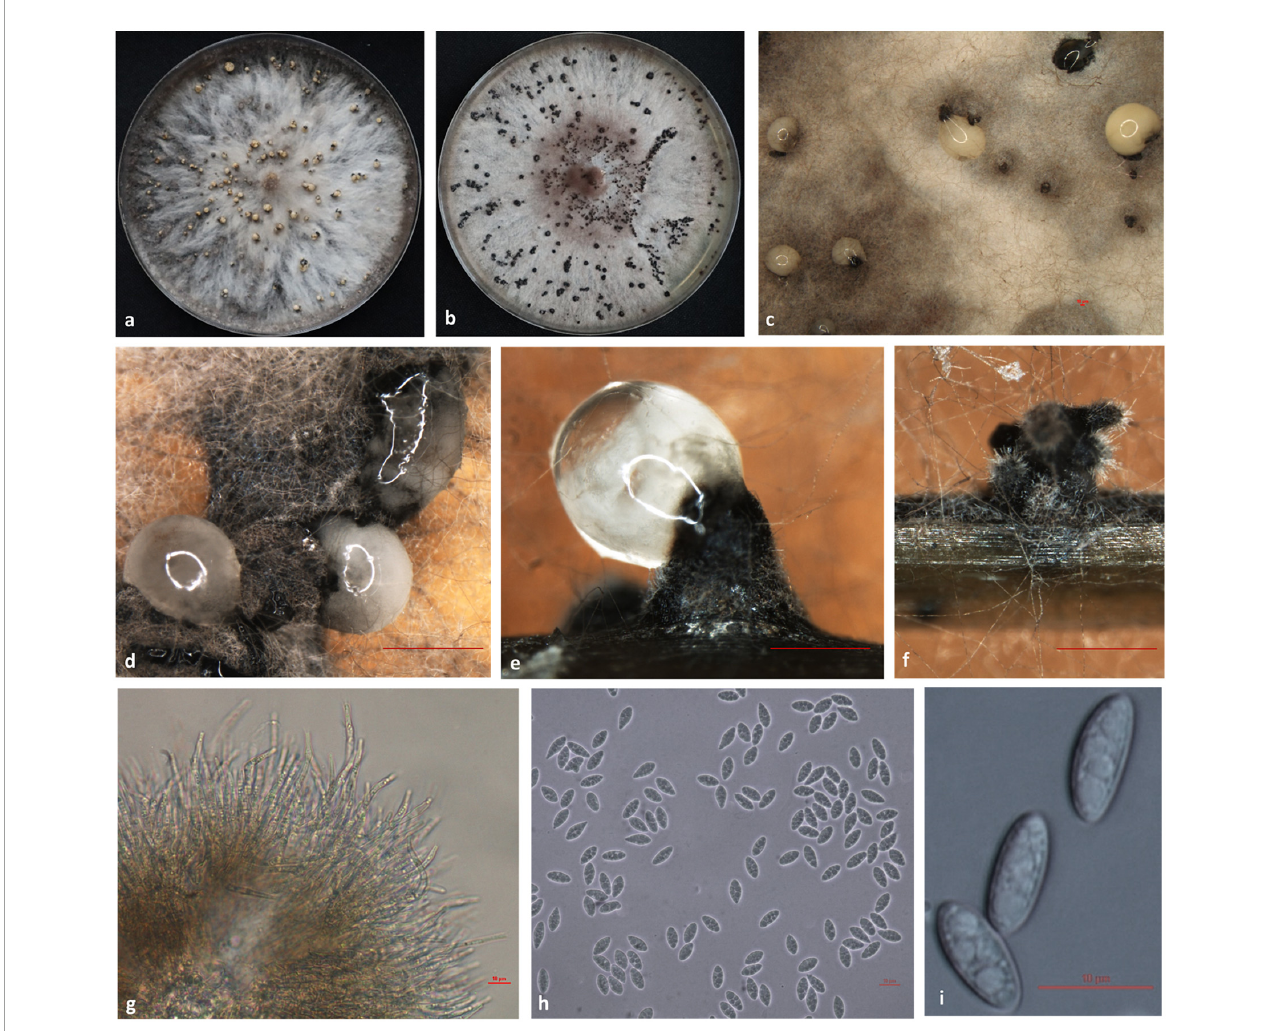
FIGURE2 Morphological characteristics of Diaporthe atlantica . Colony appearance on potato dextrose agar (PDA) (a) and malt extract agar (MEA) (b) ; conidiomata with conidial droplets on PDA (c,d) ; conidiomata on pine needle (e) and Festuca pruinosa leaves (f) ; conidiogenous cells (g) ; α -conidia (h,i) . Scale bar: panels (d–f) = 100 µ m; panels (c,g–i) = 10 µ